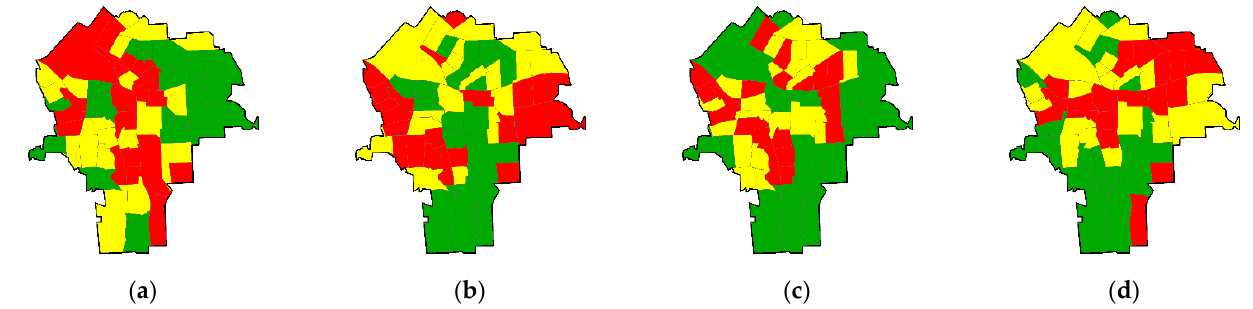
Figure 2. Tertile choropleth maps for the four aggregated trace metal error dimensions across Syracuse, NY; red denotes relatively high factor scores, yellow denotes intermediate factor scores, and green denotes relatively low factor scores. ( a ) Factor-1 (MC = 0.185, GR = 1.038); ( b ) Factor-2 (MC = 0.242, GR = 0.800); ( c ) Factor-3 (MC = 0.162, GR = 0.725); ( d ) Factor-4 (MC = 0.300, GR = 0.618).